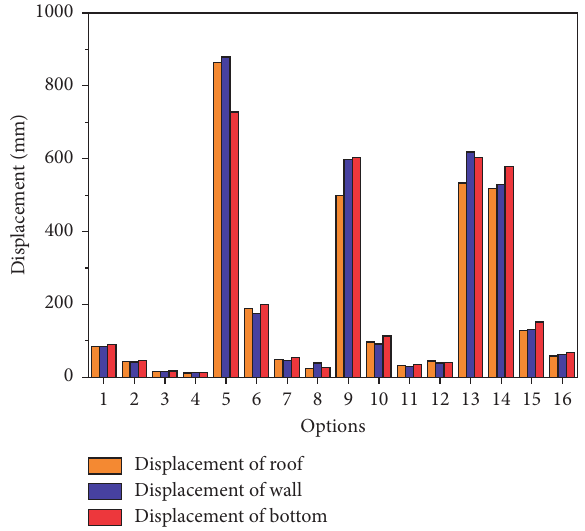
Figure 9: Displacement of different schemes. Table 7: Sensitivity analysis.